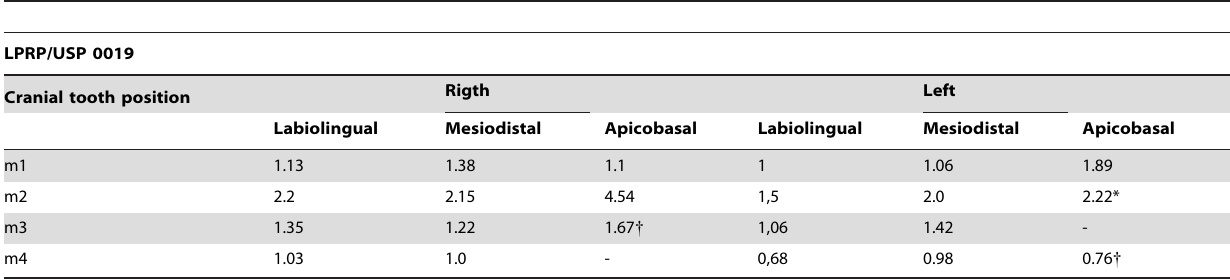
Table 3. Maximum labiolingual and mesiodistal diameters, and apicobasal length (in cm) of premaxillary maxillary (m) tooth crowns of LPRP/USP